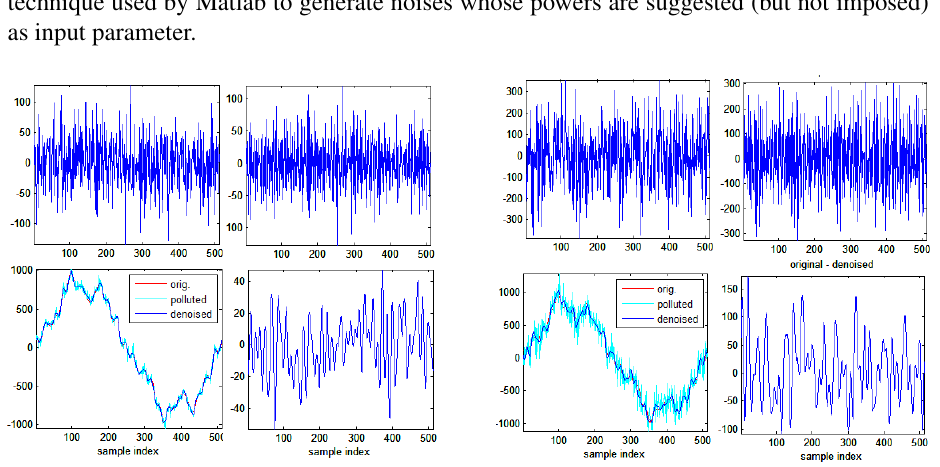
Figure 8. Results yielded by the WPT based de- noising algorithm, for maximum noise, 1-st set.